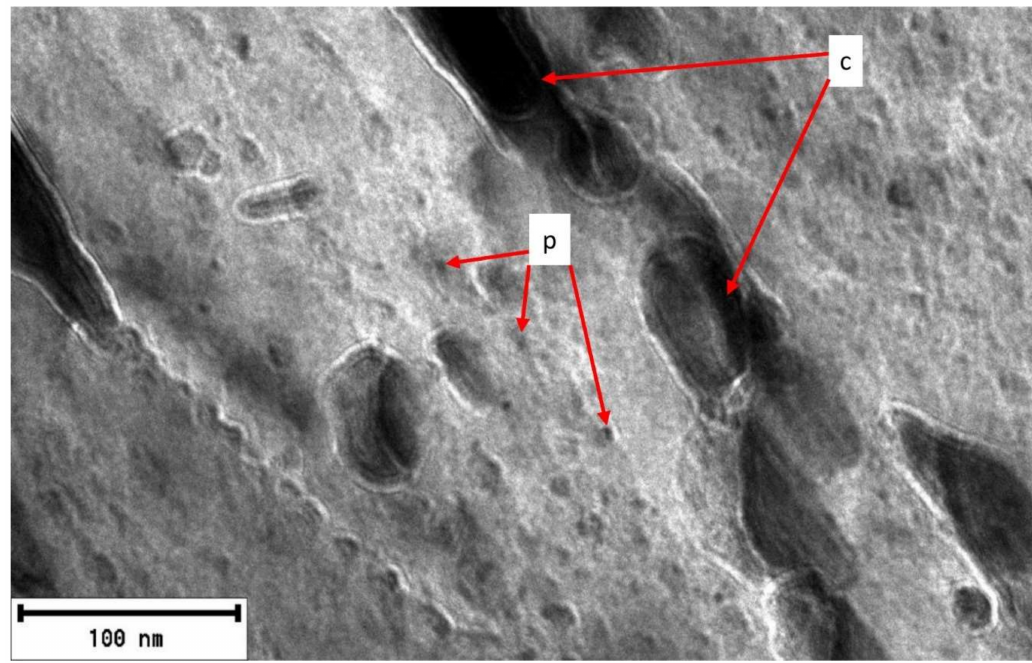
Figure 6. TEM bright field image of the sample 1.5Cu QT 500 ◦ C / 60 min. There are dark elongated particles of carbides (c) and small round precipitates (p) within the ferrite matrix.